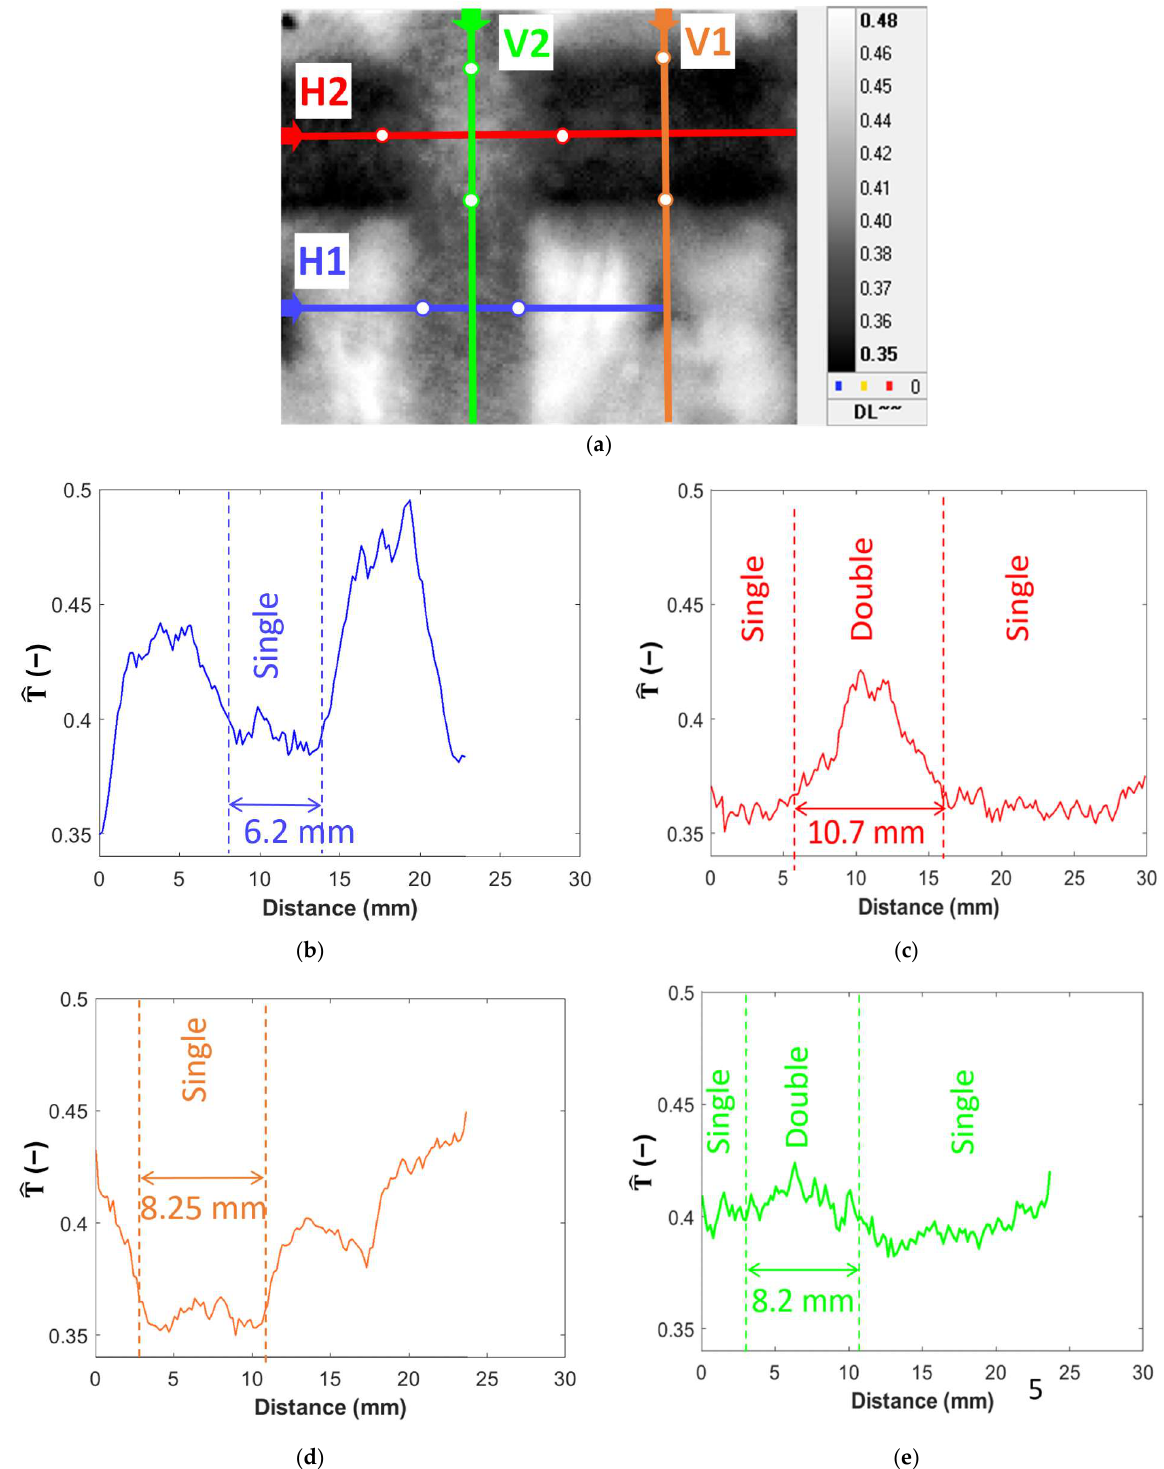
Figure 7. Normalized thermal data along linear profiles, at t = 1/472 s: ( a ) profile selection from the normalized thermal map of the ROI. The arrows indicate the origin of each profile, and the white dots are the regions evidenced in the next sub-figures; ( b ) normalized thermal trend along profile H1; ( c ) normalized thermal trend along profile H2; ( d ) normalized thermal trend along profile V1; ( e ) normalized thermal trend along profile V2. After this thermographic analysis, the samples S1 and S2 were cut from the panel for microscopic analyses. The sample S1 was embedded into resin for the